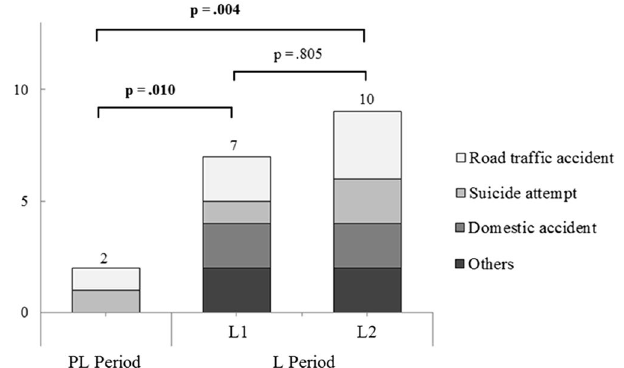
Figure 3. Stacked bar graph representation of high severity trauma (ISS > 16) according to the mechanism and the PL, L1, and L2 periods, with significant differences in the Fisher’s exact test. Others: L1: one assault, one work accident; L2: one sports accident, one work accident. PL: Pre-lockdown (from 02/18/20 to 03/16/20), L: Lockdown (from 03/17/20 to 05/11/20), L1: Early lockdown (from 03/17/2020 to 04/14/2020), L2: Late lockdown (from 04/14/2020 to 05/11/2020); ISS: International Severity